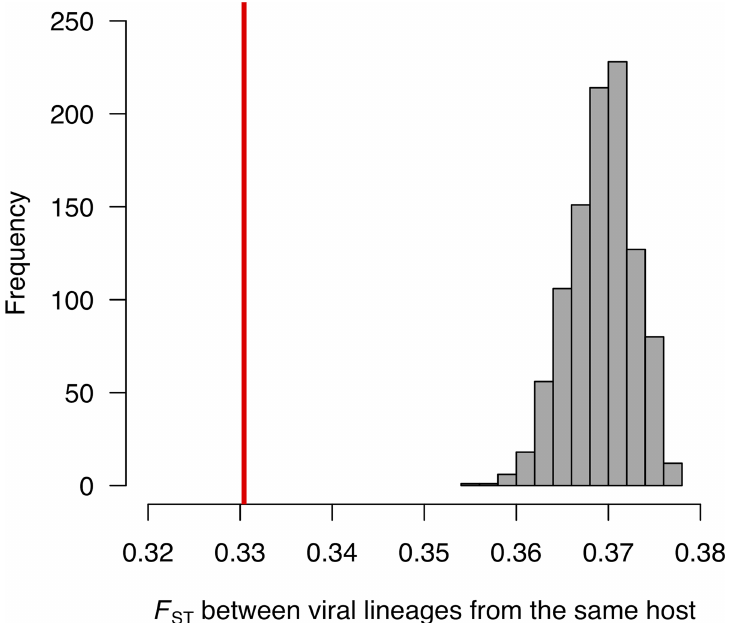
Fig 2. Viral lineages from the same host species were genetically more similar to each other than to lineages from different host species. The mean pairwise F ST between all possible pairs of viral lineages from the same host species was calculated. The red line shows the observed value. The grey bars are the null distribution of this statistic obtained by permuting the viral lineages across host species 1000